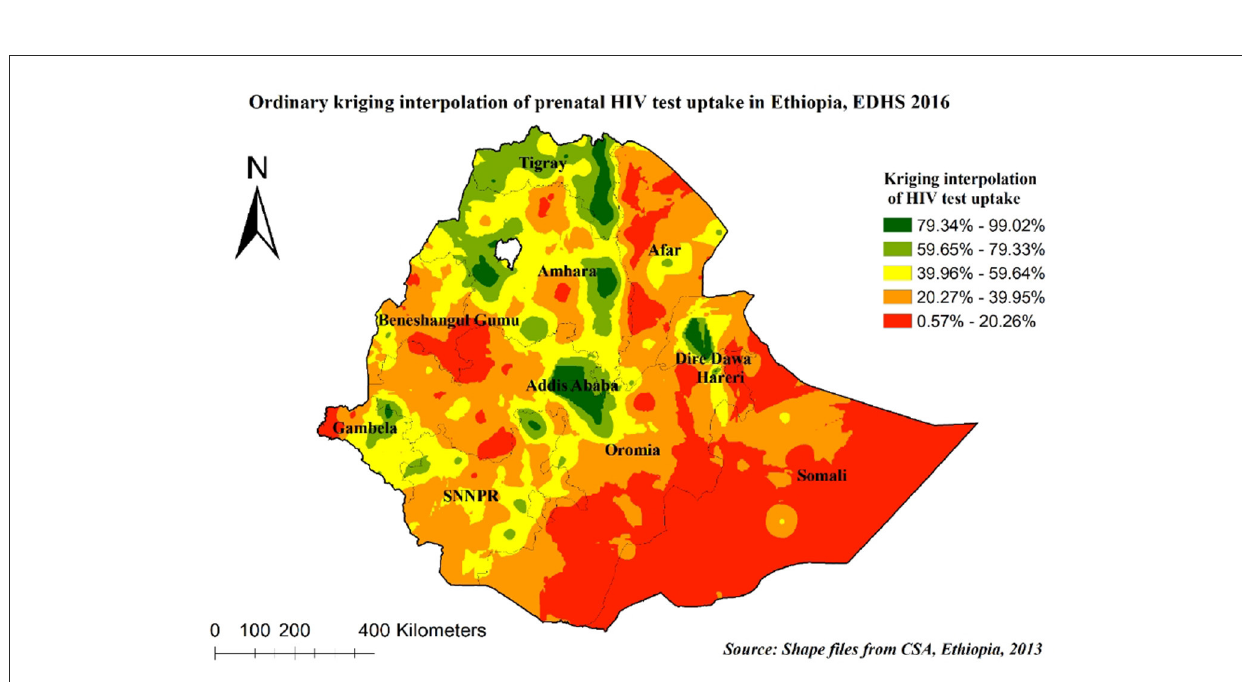
FIGURE5 Kriging interpolations of prenatal HIV test uptake in Ethiopia, 2016.